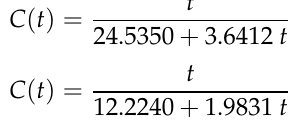
Figure 3. Kinetic Model, 2 mm matrix. Statistical values are reported in Table A2.